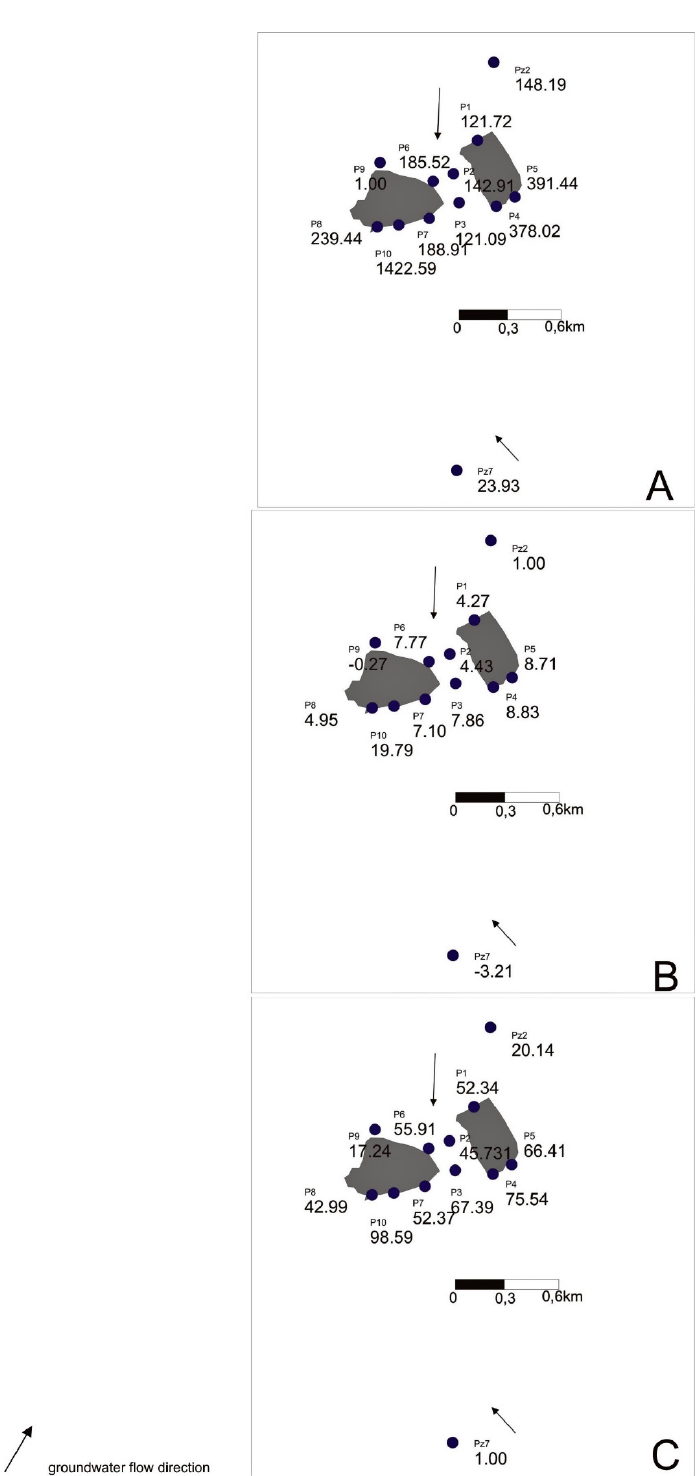
Figure 4. Values of the Contamination index using the results from different piezometers as hydro- chemical background: ( A ) P9, ( B ) Pz2, ( C )